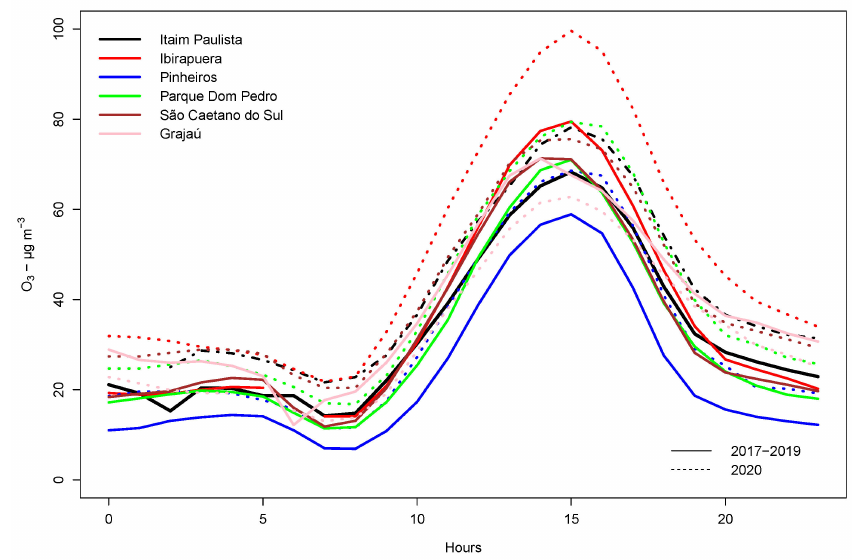
Figure 10. O 3 hourly concentration for MASP during April–May 2017–2019 (pre-pandemic) and 2020 (during the pandemic) from ground-level